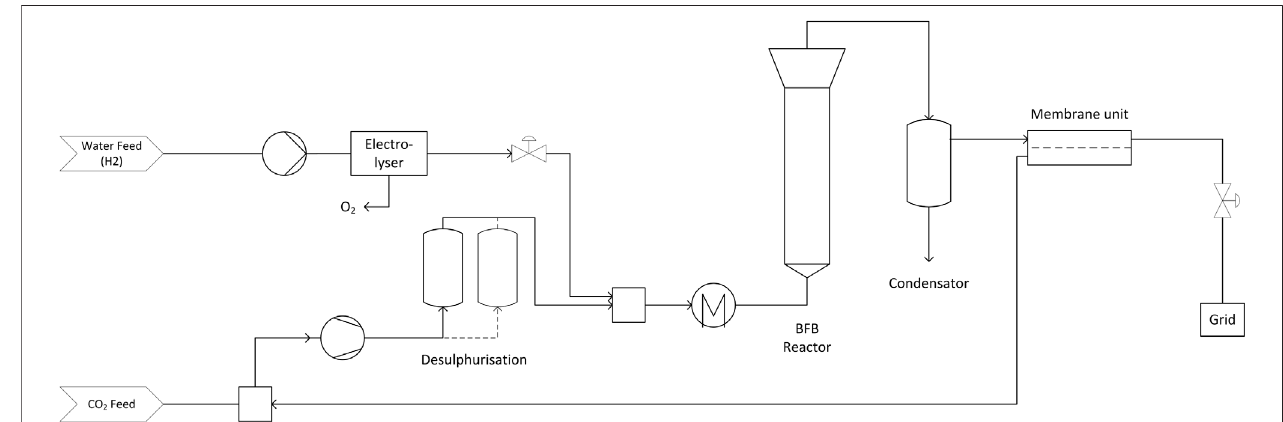
FIGURE 2 | Process chain for bubbling fl uidised bed methanation of CO 2 using a PEM electrolyser as hydrogen